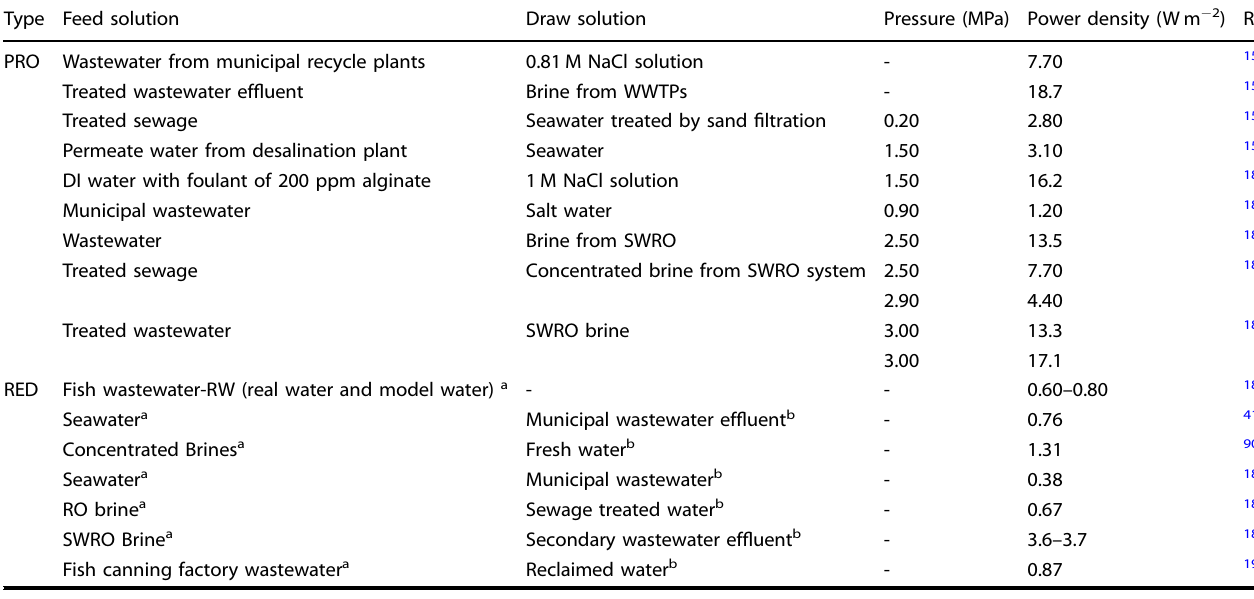
a represents the concentrate stream in RED processes. b represents the dilute stream in RED processes.